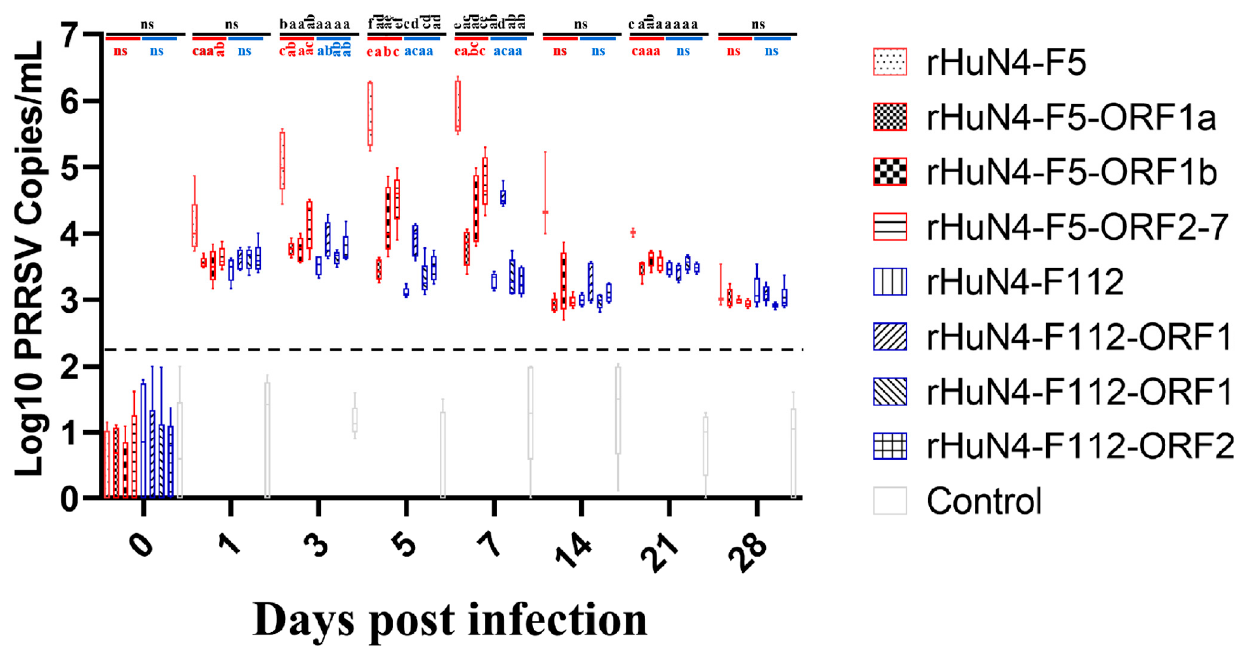
Figure 4. Serum viral copies of each group. The serum viral copies of the rescued viruses and their parental virus were showed with means ± standard deviations. Chimeric viruses with HuN4 backbone were showed with red border, chimeric virus with HuN4-F112 backbone were showed with blue border. The results of serum viral copies among all the groups were showed in black alphabets above the black line, the results of rHuN4-F5 and chimeric viruses with rHuN4-F5 backbone were showed in red alphabets below the red line, the results of rHuN4-F5 and chimeric viruses with rHuN4-F5 backbone were showed in blue alphabets below the blue line. Results were showed with single alphabet, or a range of alphabets which were represented by the first and last alphabet.The results which share same alphabet or showed as “ns” means p ≥ 0.05; results do not share same alphabet but have adjacent alphabets with each other means p < 0.05; results do not share same alphabet or adjacent alphabets with each other means p < 0.01. Results among all the viruses were showed with black alphabets above the line, results among HuN4-F5 backbone chimeric viruses were showed with red alphabets below the line, and results among HuN4-F112 backbone chimeric viruses were showed with light blue alphabets below the line.